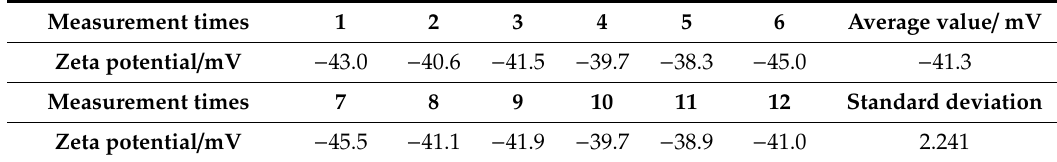
Table 3. Zeta potential of nano-C 60 modified insulating oil (CMIO) (100 mg/L, pH=7).